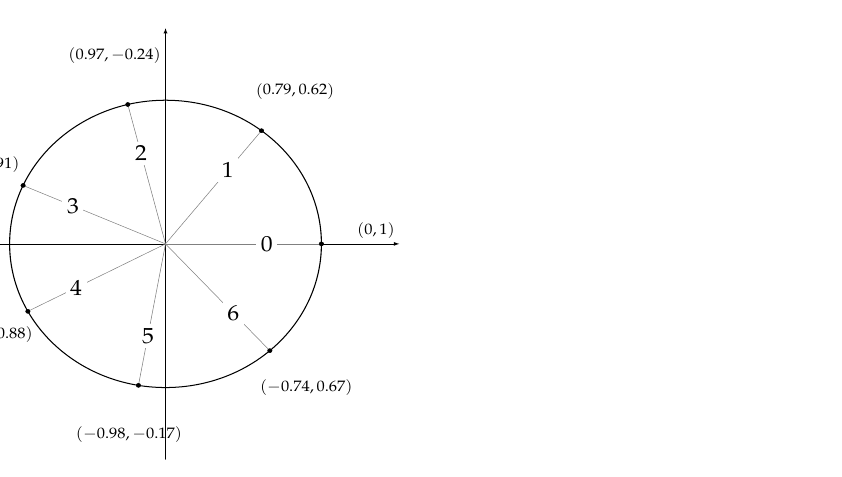
Figure 5. Values assigned to ( dow_sin , dow_cos ) after a trigonometric transformation of the dow feature, where dow ranges from 0 (Monday) to 6 (Sunday).